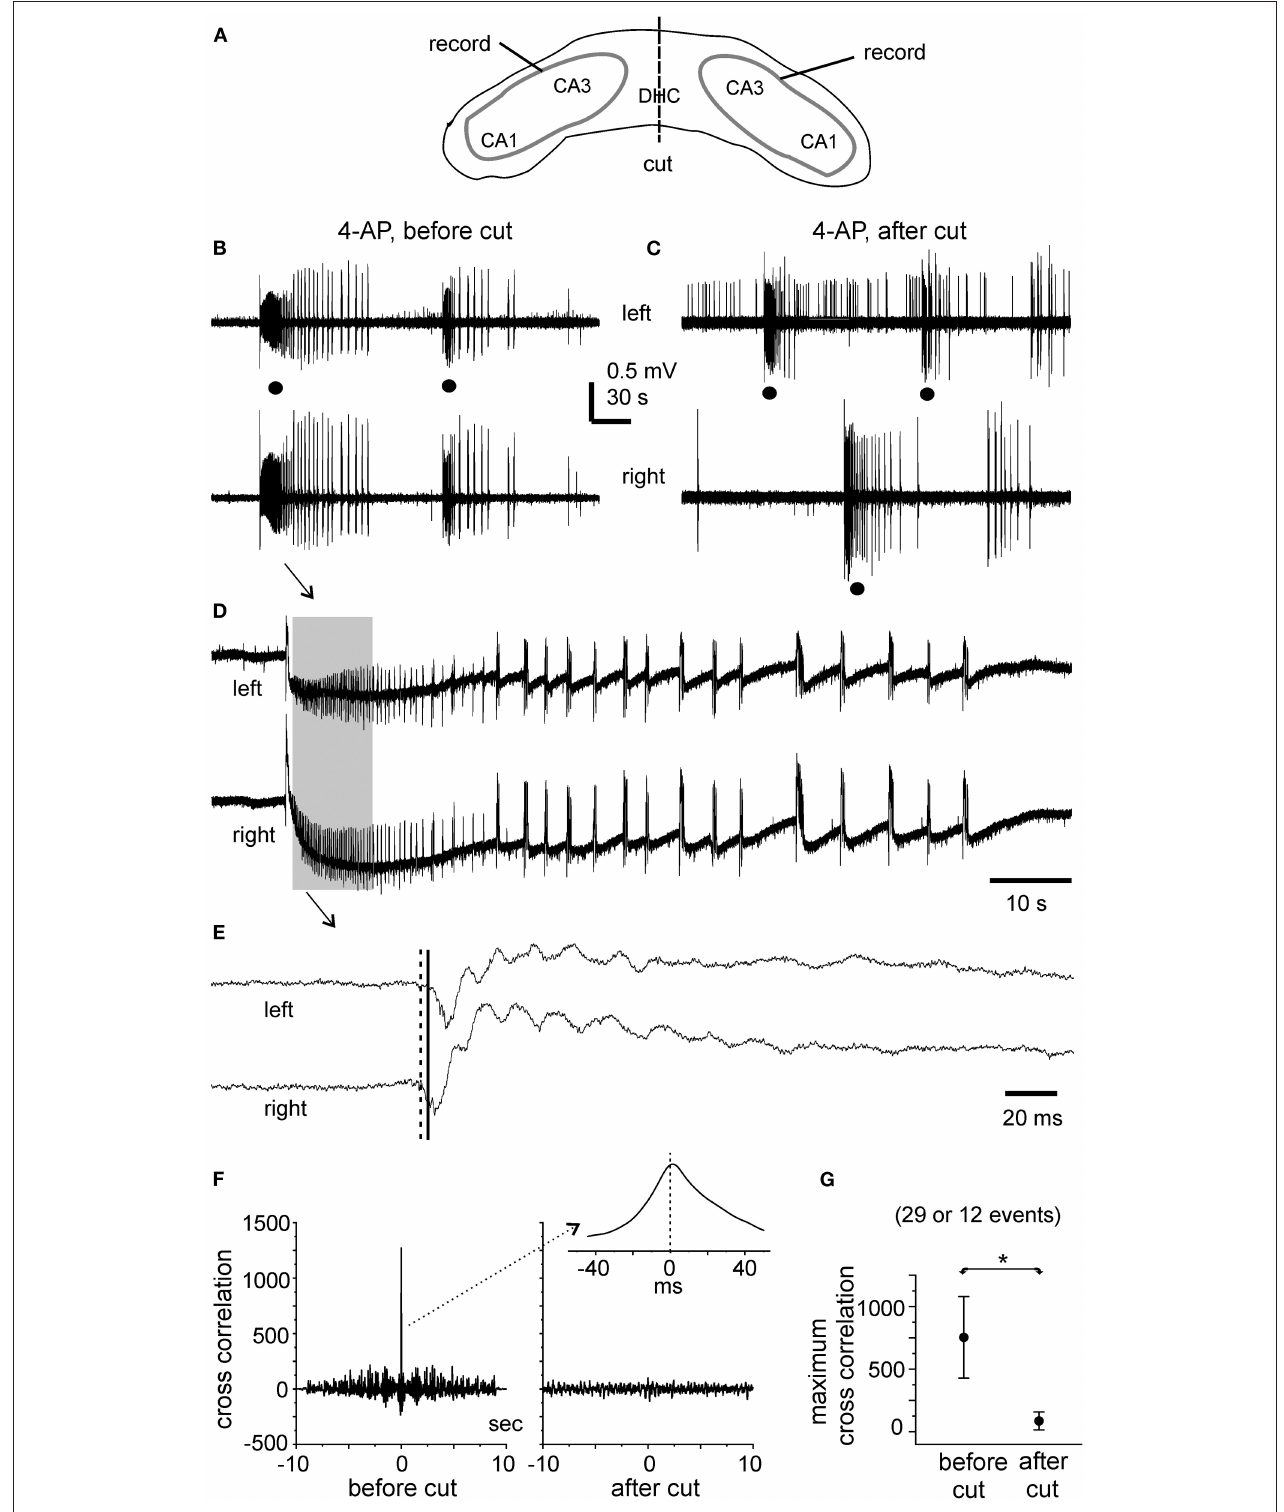
FIGURE 5 | Bilateral ictal discharges observed before and following a cut at DHC. (A) A diagram showing the positions of the recording electrodes. (B – E) A bilateral hippocampal slice prepared from a 22-day-old mouse. Self-sustained ictal discharges (filled circles) induced by 100 µ M 4-AP and illustrated after treatment with